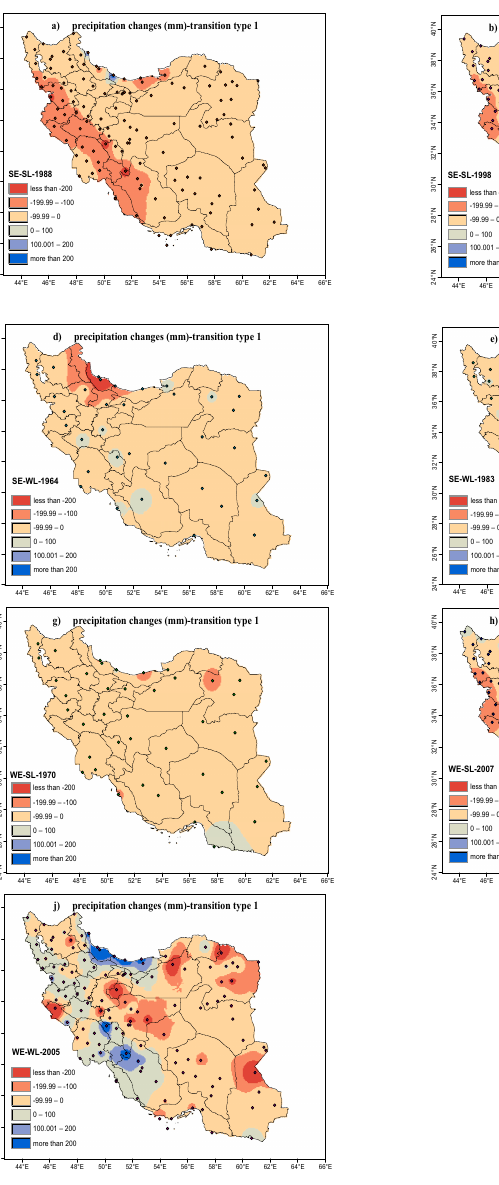
In type 2 transitions, as Figure 4 shows, wave activity values were generally larger